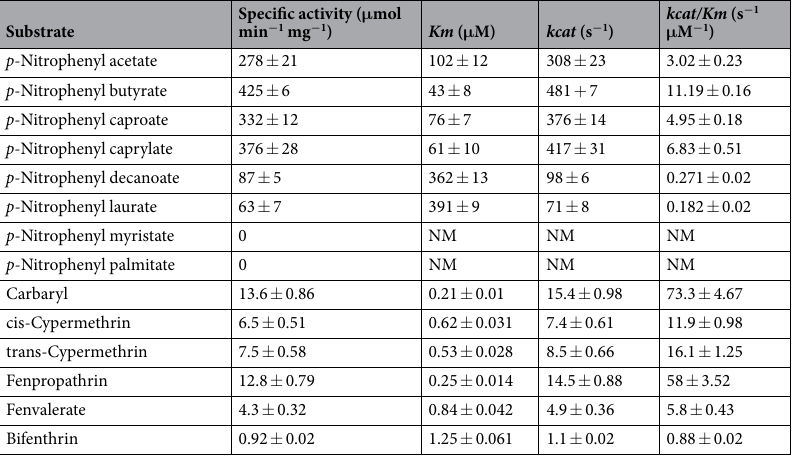
Table 2. Substrate specificity of recombinant